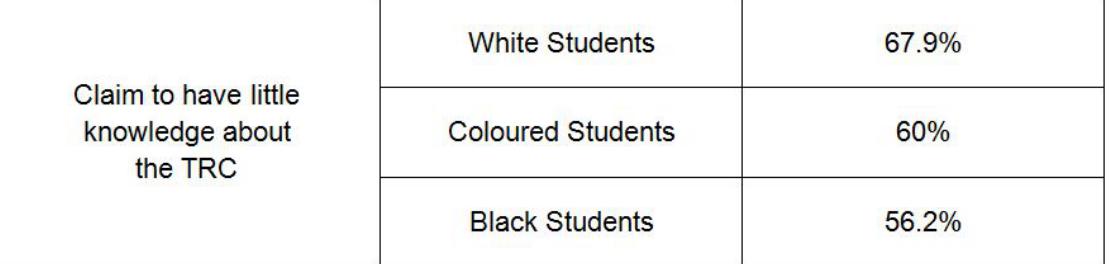
Table 1: Descending order of alleged knowledge about the